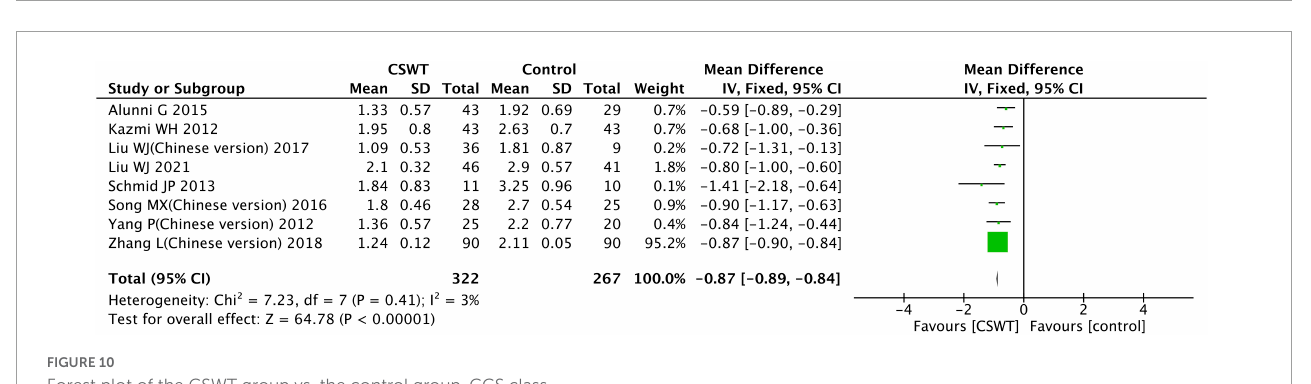
FIGURE9 Forest plot of the CSWT group vs. the control group-SAQ score.